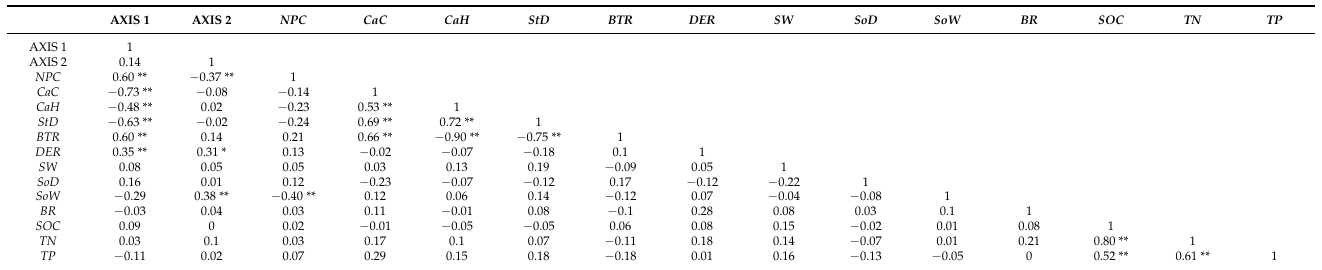
Table 6. The correlation coefficients of axes, seven stand factors and six soil factors at bamboo– woodland interface plots in Jiangxi province, China.